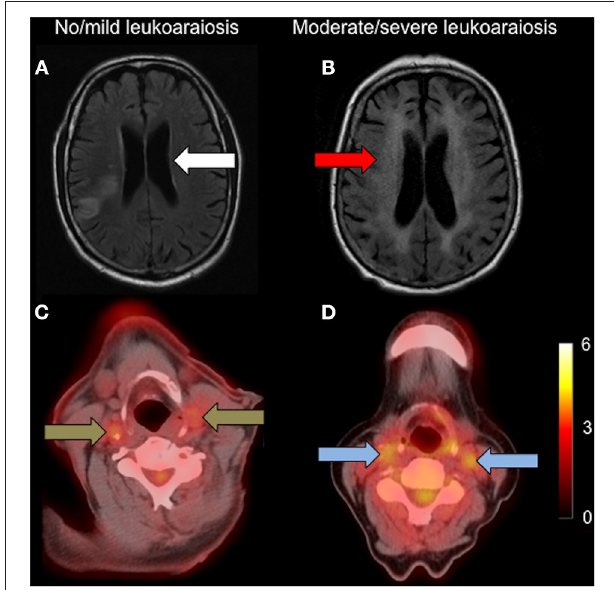
FIGURE 1 | Carotid FDG uptake according to leukoaraiosis severity. Left: (A) : axial FLAIR showing no/mild leukoaraiosis (white arrow) with (C) : associated low carotid FDG uptake (brown arrows); Right: (B) : axial FLAIR showing moderate/severe leukoaraiosis (red arrow) with (D) : higher associated carotid FDG uptake (blue arrows). Both FDG-PET/CT images are set to the same scale, with the scale bar showing FDG SUV.